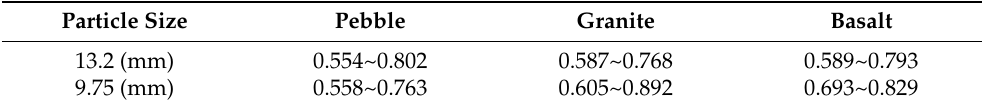
Table 2. Statistics of fitting ellipsoid